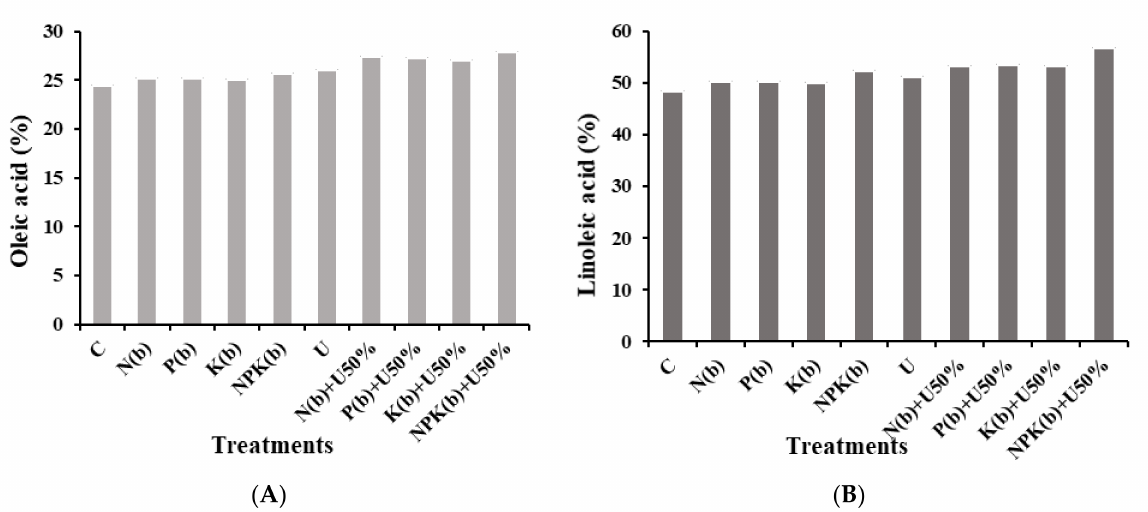
Figure 3. Means comparison for oleic acid ( A ) and linoleic acid ( B ) of Nigella sativa L. as influenced by biofertilizers and chemical urea (chemical urea fertilizer (U), biofertilizer N (b) , biofertilizer P (b) , biofertilizer K (b) , mixed biofertilizer NPK (b) , 50% urea + biofertilizer N (N (b) + U 50% ), 50% urea + biofertilizer P (P (b) + U 50% ), 50% urea + biofertilizer K (K (b) + U 50% ), and 50% urea + biofertilizer NPK (NPK (b) + U 50%